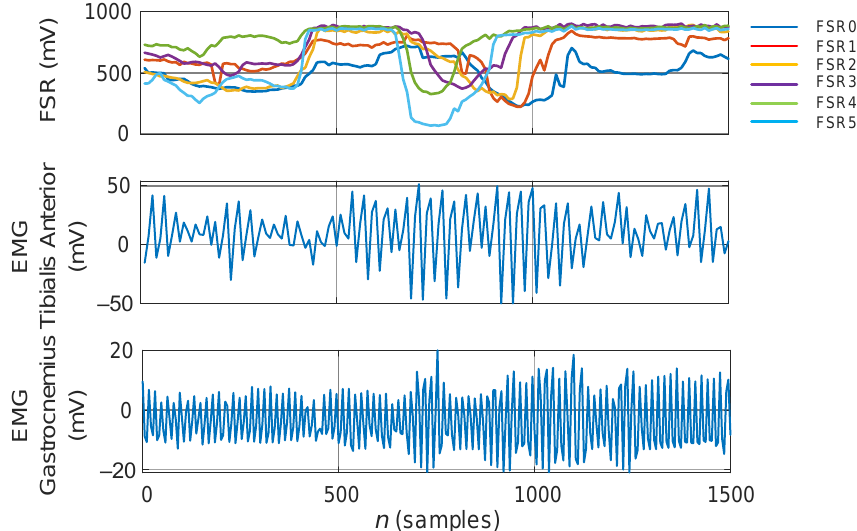
Figure 19. The FSR recordings during a stance phase, plotted alongside the tibialis anterior and gastrocnemius EMG respectively.